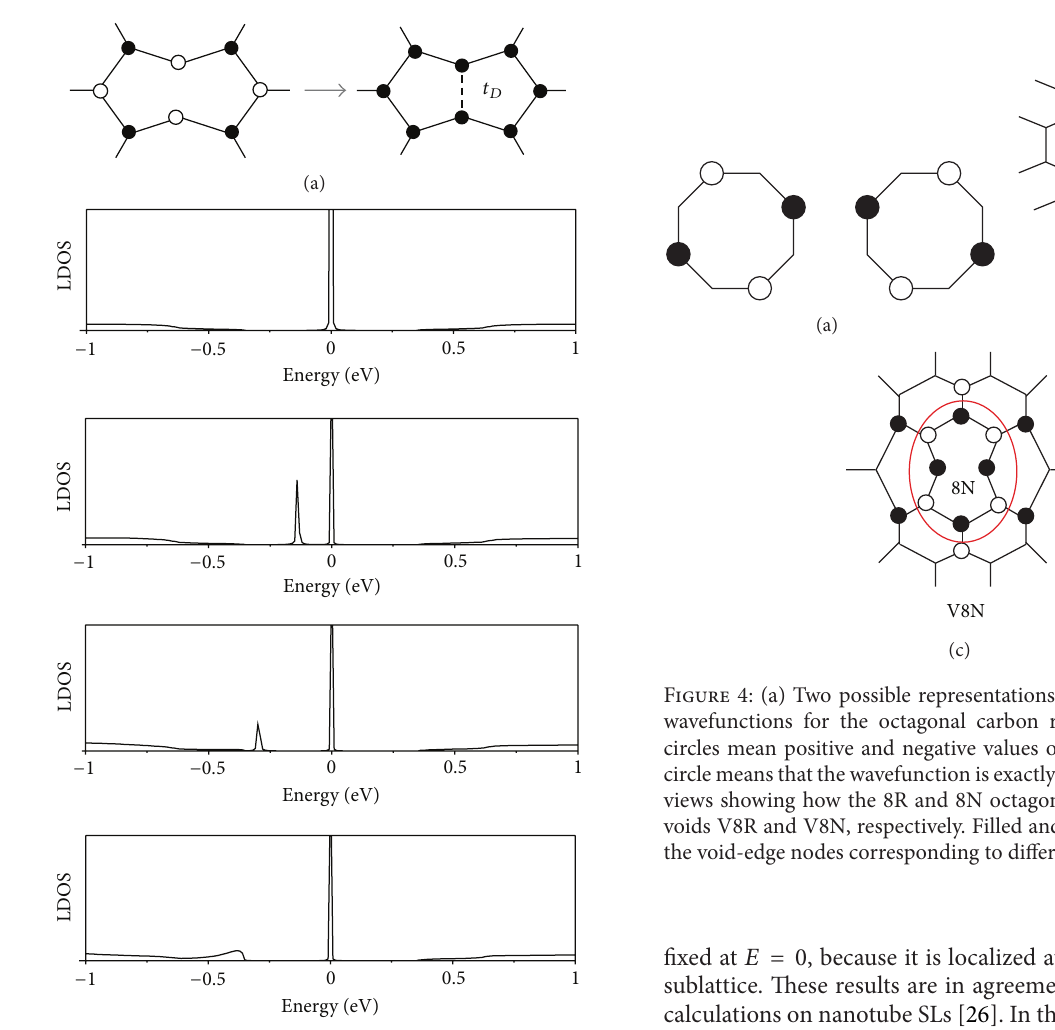
in principle mix, split, and merge into the bulk continuum.